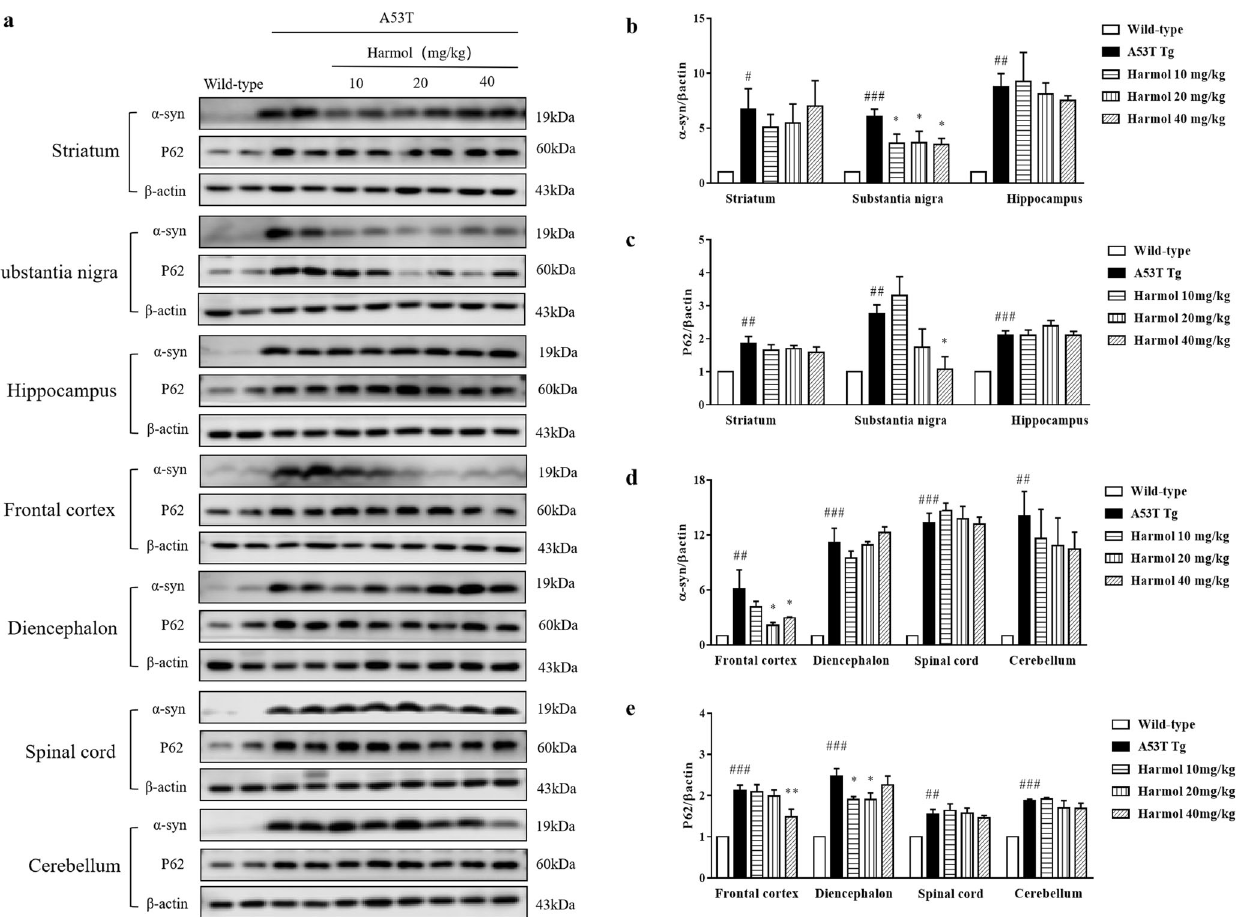
Fig. 6 Harmol attenuates α -syn and p62 load in the substantia nigra and prefrontal cortex of A53T α -syn mice. a A53T α -syn mice were treated with 10, 20, and 40 mg/kg harmol for 1 month. The levels of α -syn and p62 in different brain regions were determined by western blot. Representative blots are shown. b – e Relative intensity was normalized to that of β -actin. Data are presented as the mean ± SEM. # P < 0.05, ## P < 0.01 and ### P < 0.001 vs. the wild-type (saline). * P < 0.05 vs. the A53T